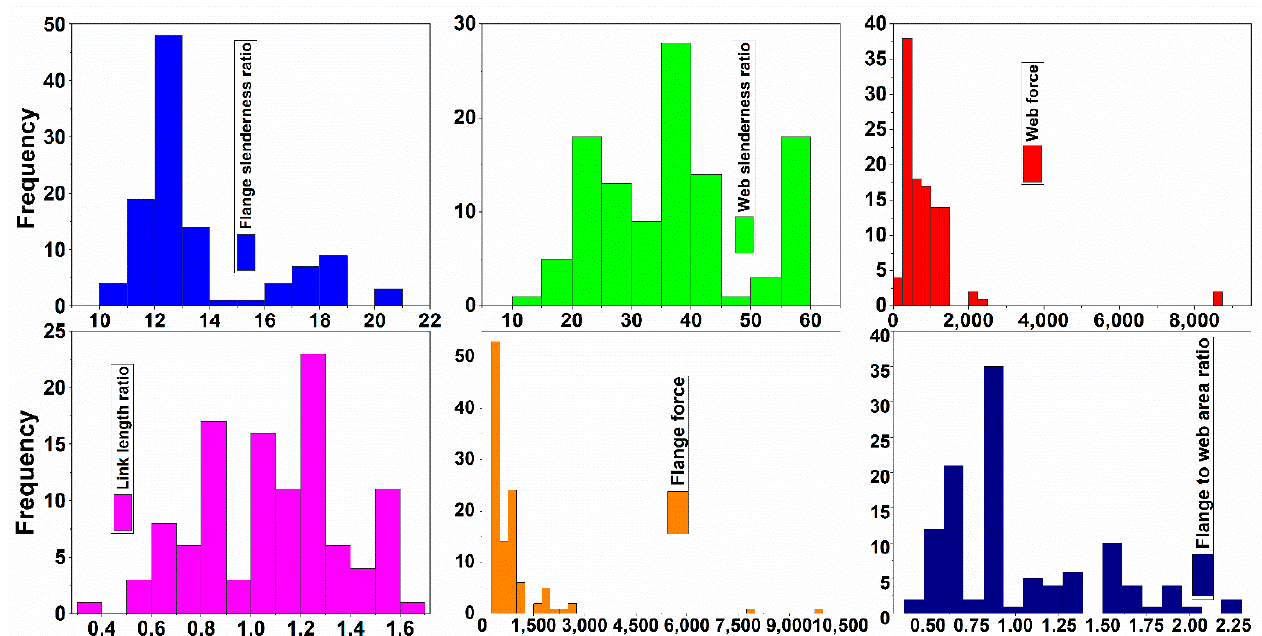
Figure 6. Database statistical description.